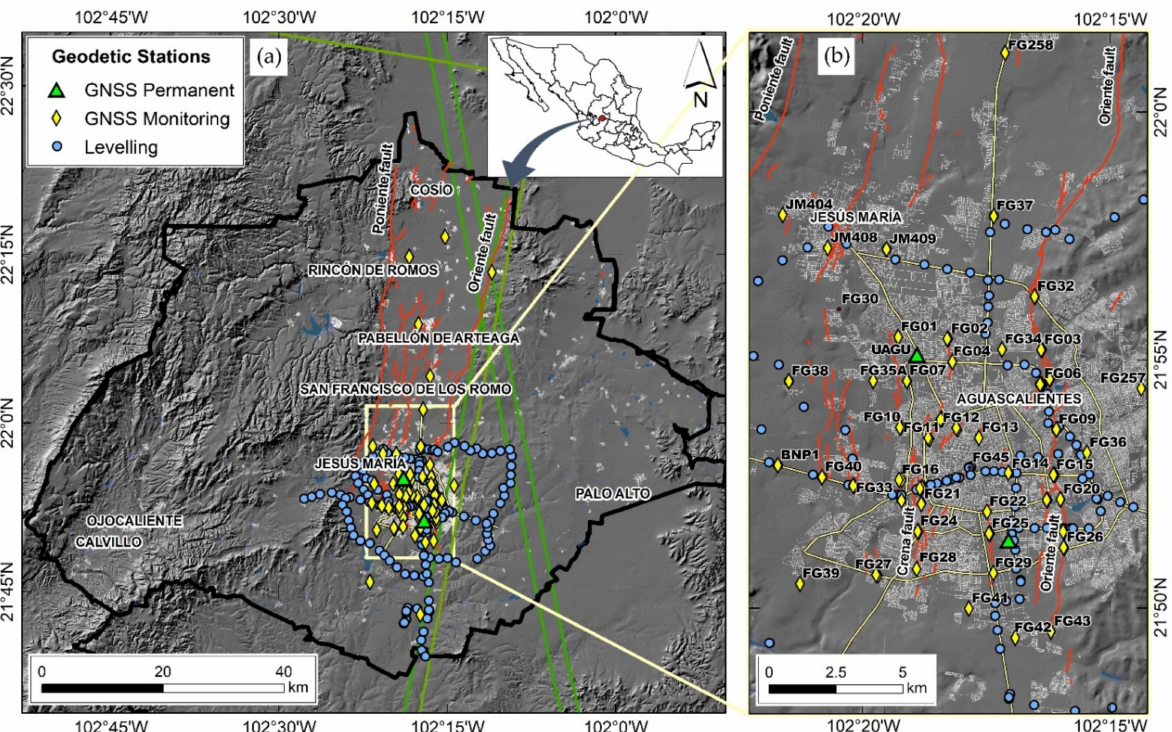
Figure 1. Location of geodetic stations in Aguascalientes state ( a ) and in Aguascalientes city in detail ( b ). The study area is near the geographic centre of Mexico, 340 km north-west from Mexico City. Red lines in the maps are the trace of faults detected up to 2015 [32], and green lines are the footprints of subswaths 1 and 2 of the Sentinel-1 IW beam mode images acquired along ascending and descending